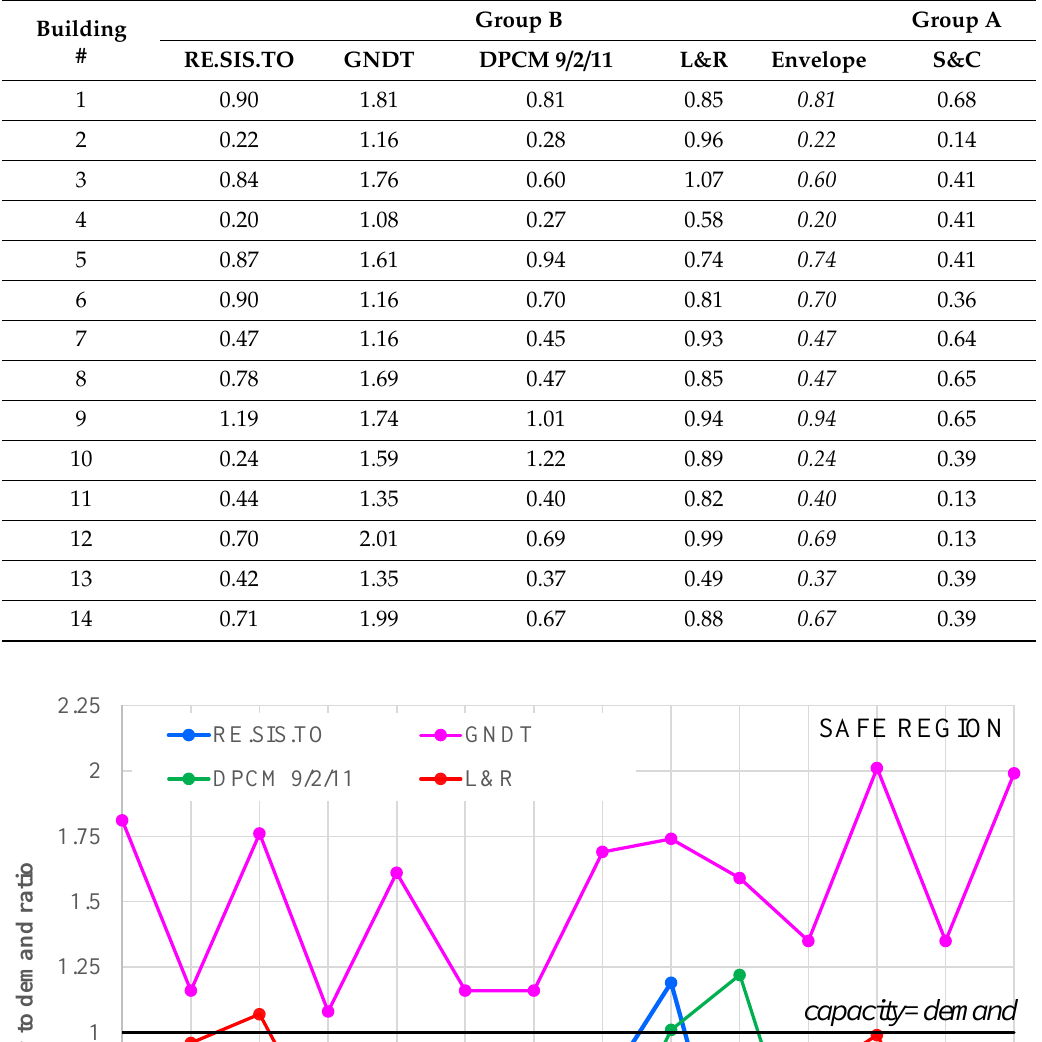
Table 14. Comparison of quantitative vulnerability judgments in terms of the capacity-to-demand ratio.